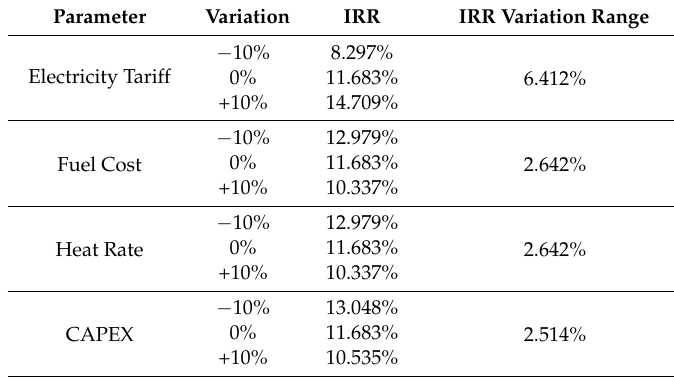
Table 8. Summary of sensitivity analysis: IRR from parameter